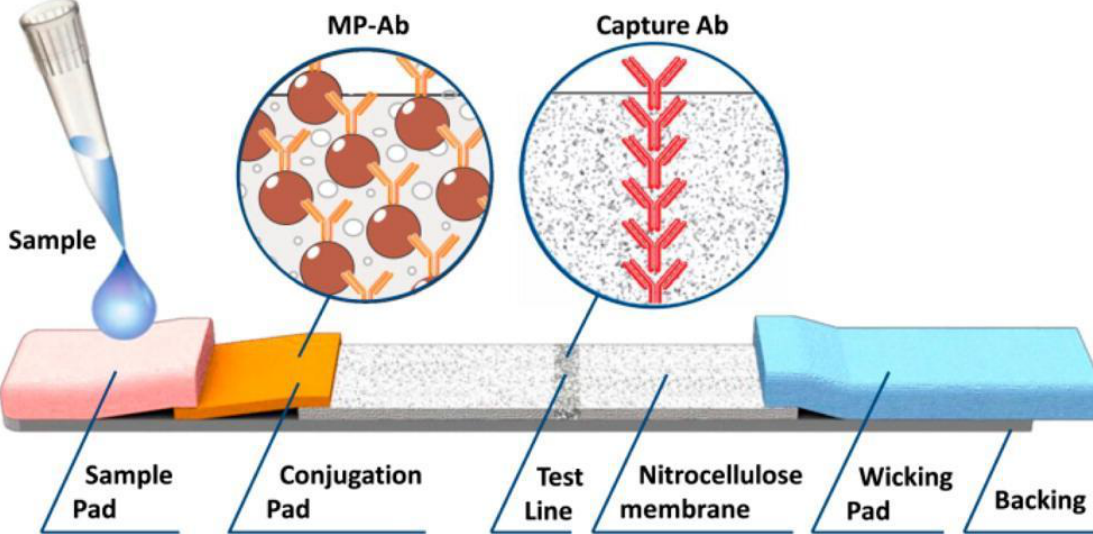
Figure 5. Schematic of a test strip based on sandwich-lateral flow assay with antibody-conjugated magnetic particles as labels (Reproduced with permission from [39]. ACS Publications,